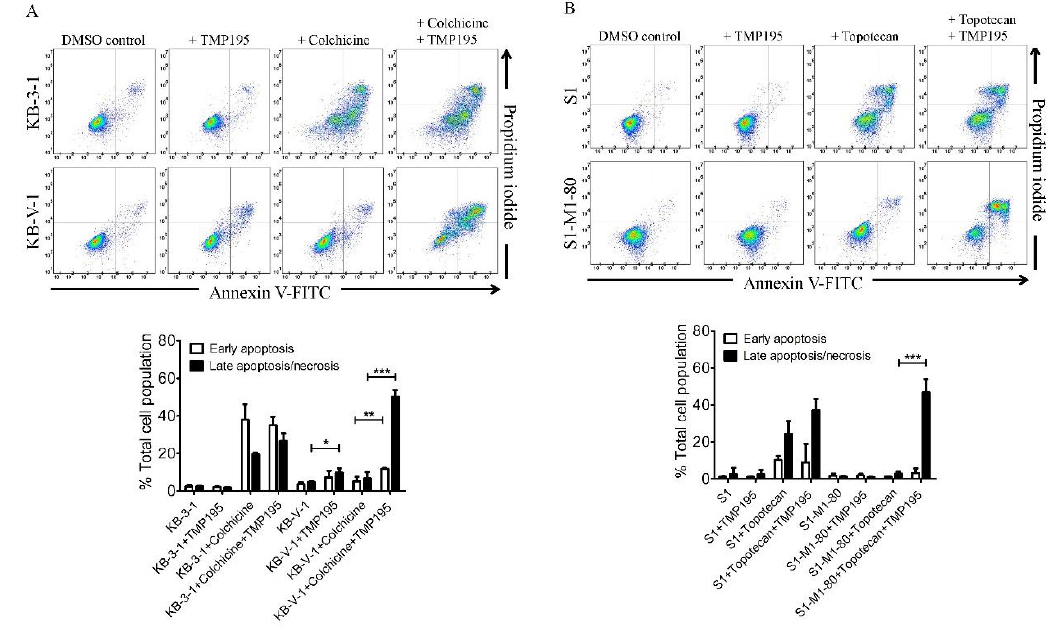
Figure 2. TMP195 enhances drug-induced apoptosis in ABCB1-overexpressing cancer cells and ABCG2-overexpressing cancer cells. Dot plots (upper panel) and quantification (lower panel) of ( A